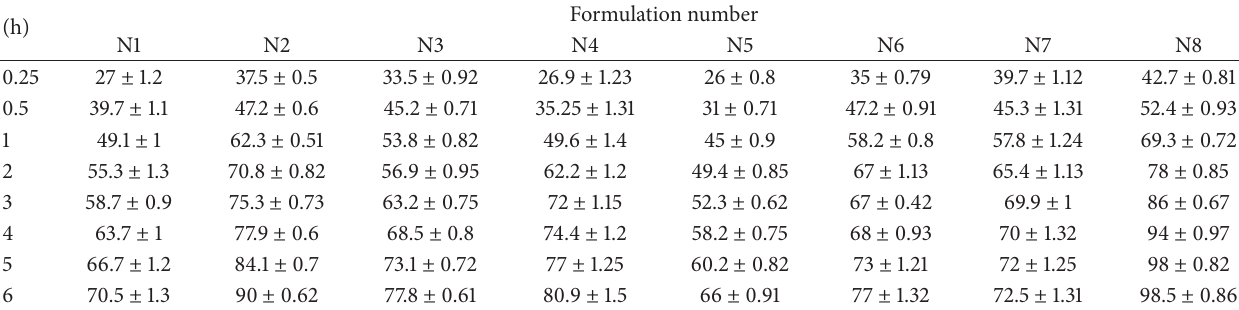
Figure 1: (a) FT-IR spectra of formulation N6 . Red, API-free formulation; pink, naftifine hydrochloride nail lacquer. (b) Microcalorimetric thermograph of formulation N6 . Dark blue, API-free formulation; light blue, naftifine hydrochloride nail lacquer. Duration of testing is approximately 6.5 h. Table 5: Naftifine hydrochloride release, polymer Eudragit